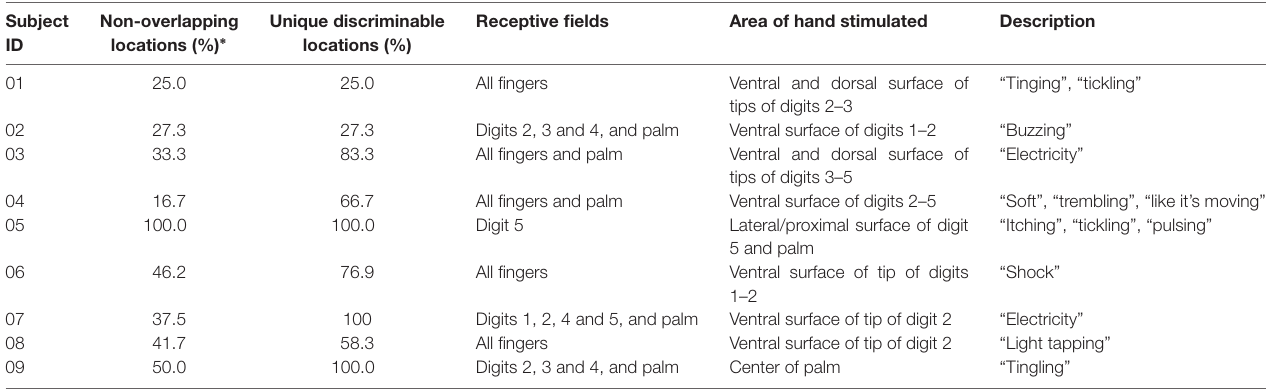
TABLE 3 | Hand receptive fields and selected stimulation site.